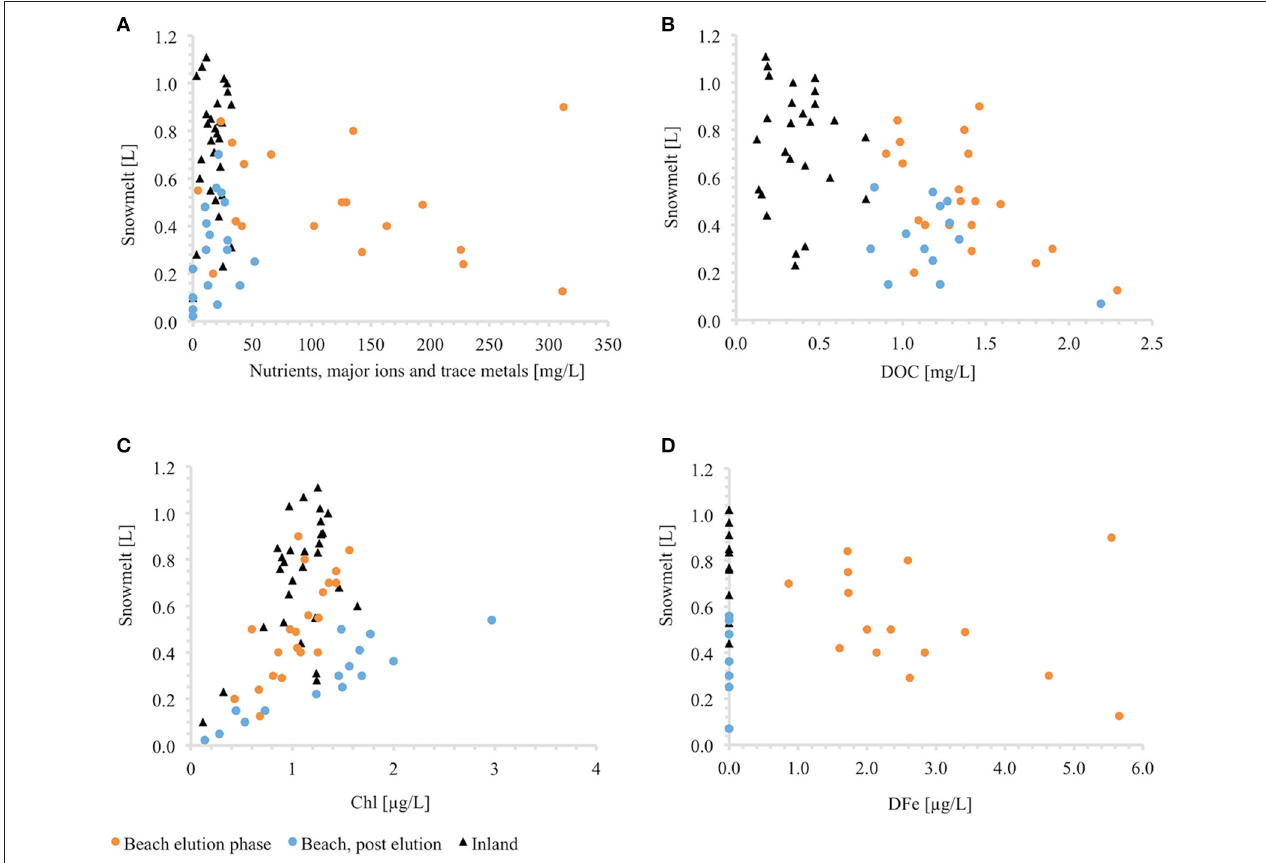
FIGURE 8 | Correlations of lysimeter discharge with concentrations of dissolved ions (A) , organic carbon (B) , in-vivo chlorophyll (C) and dissolved iron (D) at the beach and the inland sites. The elution phase represents period from 6th December 2016 until 1st January